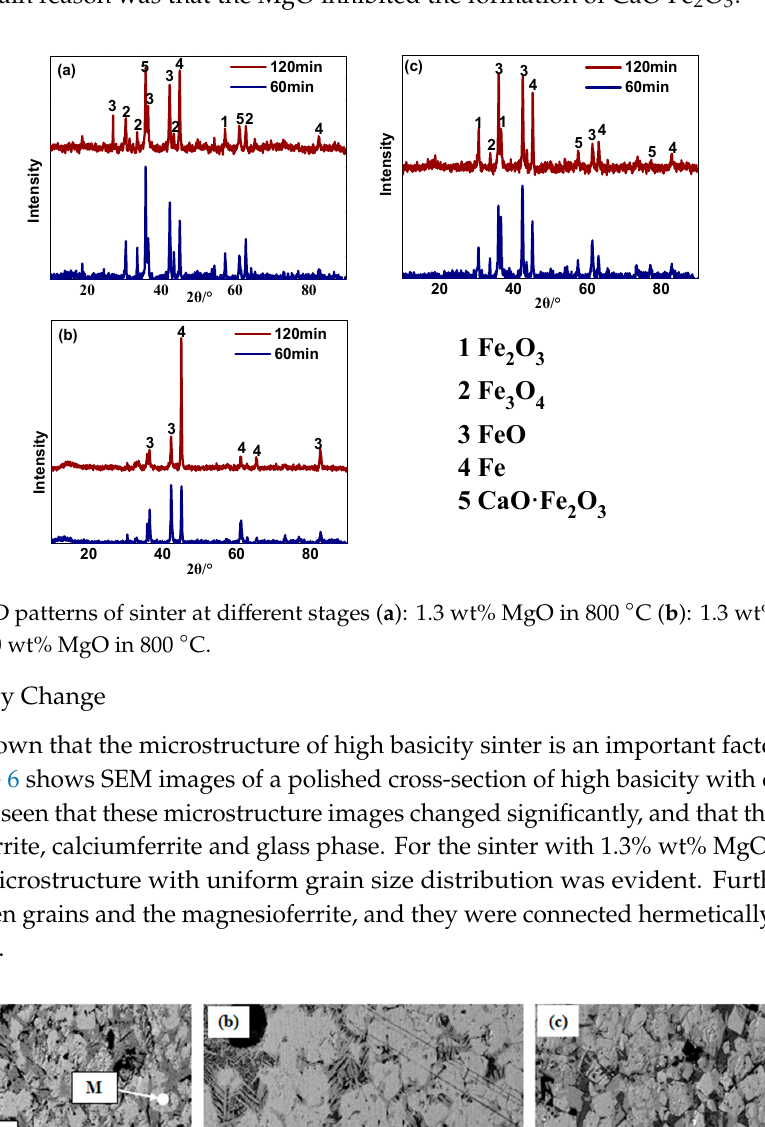
Figure 4. Reduction degree with different raw materials and temperatures: ( a ) reduction temperatures; ( b ) MgO content sinters.